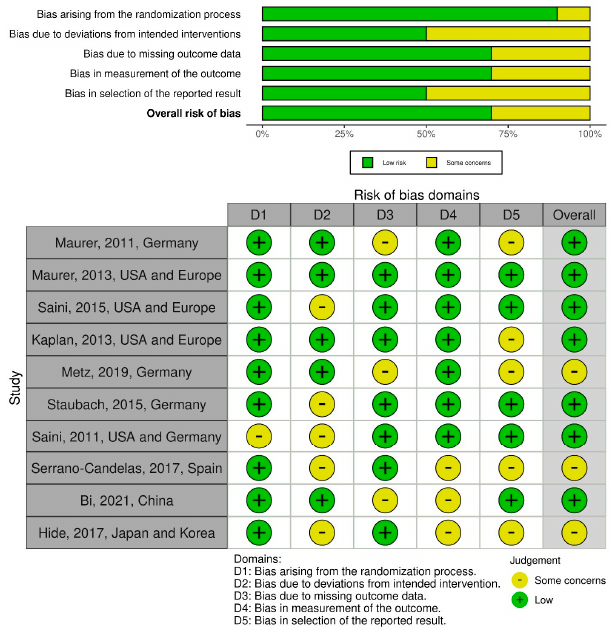
Figure 13. Risk of bias assessment of RCTs using the ROB-2 tool [17–26]. Weighted summary plot of the overall type of bias encountered in all studies and Traffic light plot of study-by-study bias assessment.